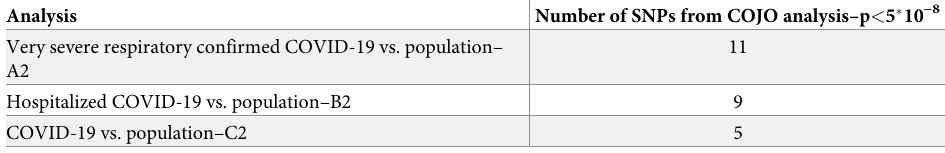
Table 1. Analysis and the corresponding number of SNPs used in the PRS.